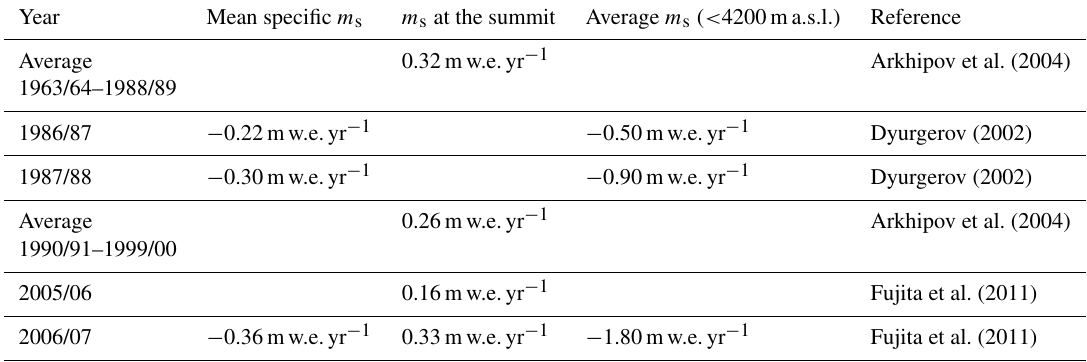
Table 3. Data used for the calibration of the mass balance model for the Grigoriev ice cap; m s represents the surface mass